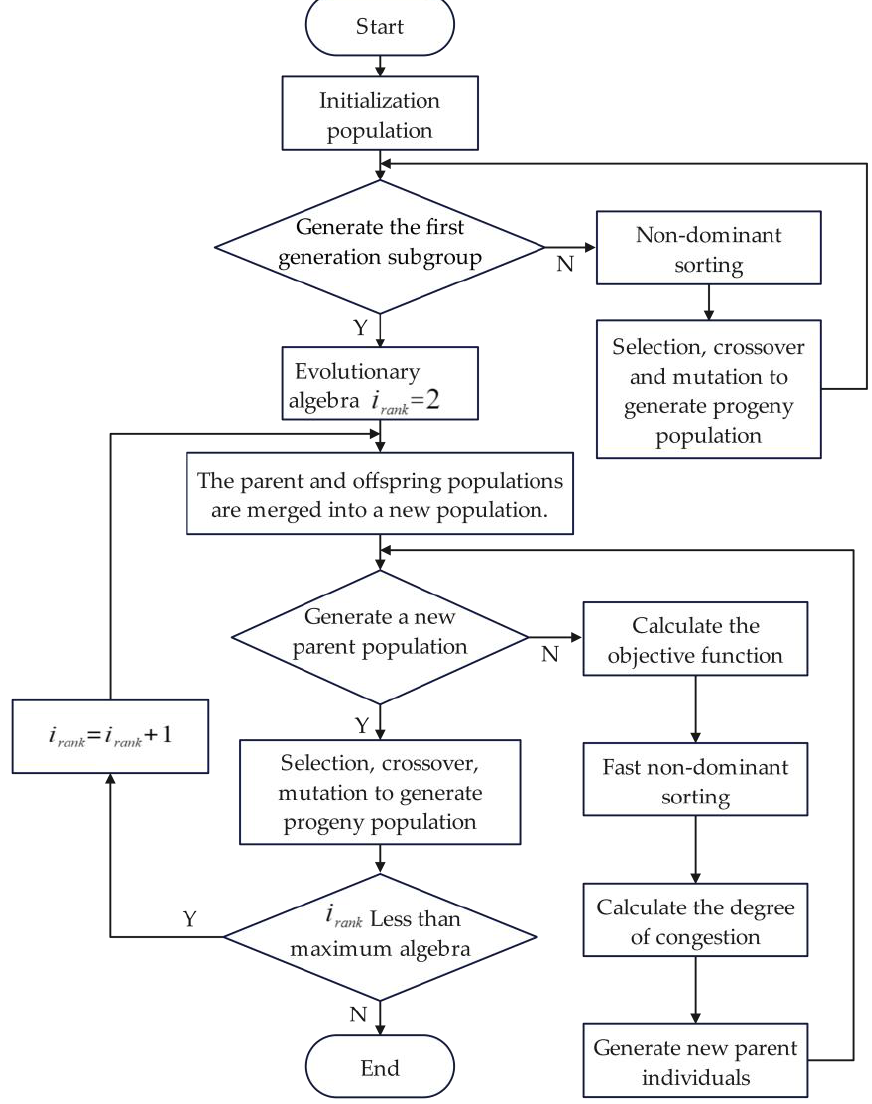
Figure 18. Optimization flow chart of NSGA-II .